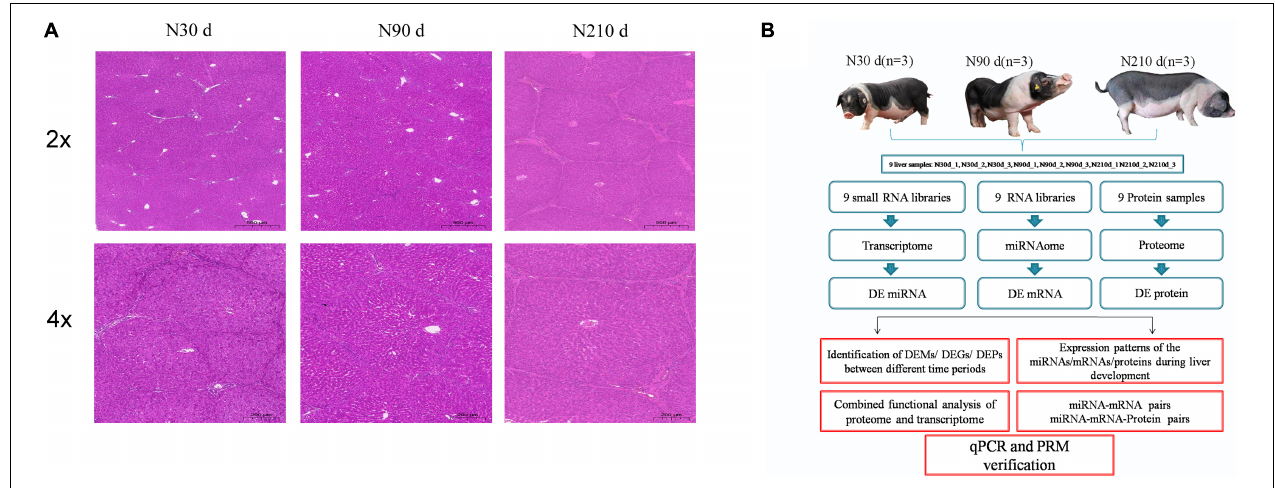
FIGURE 1 | Hematoxylin and eosin staining of spleens and overall study design. (A) H&E staining results of spleens in three developmental stages of Ningxiang pigs. (B) Schematic workflow of the experimental design of this study.